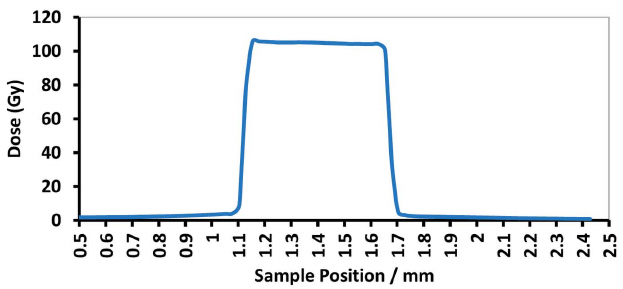
Figure 4 Dose distribution in SBB measured by IMBL PTW microDiamond. The delivered dose was 100 Gy, and the radiation field was 500 m m.